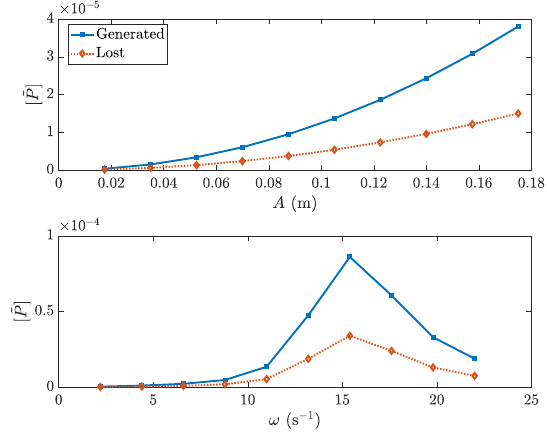
Variation of the total mean power generated (in Volt × Ampere) against the wavemaker amplitude or frequency. The mean power is calculated from (14) over the duration of one simula- tion with T = 10s . Top panel: varied wavemaker amplitude A (in m ) with fixed frequency ω = 8 . 8s − 1 . Bottom panel: varied wavemaker frequency ω (in s − 1 ) with fixed amplitude A = 0 . 0616m